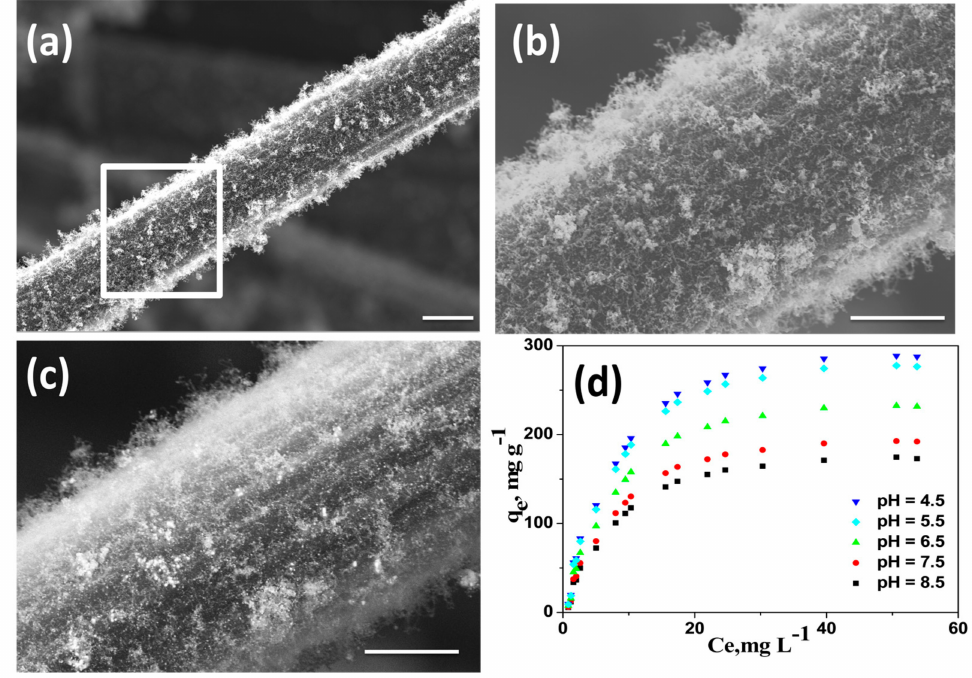
Figure 4. Representative SEM micrographs of Fe@NCNT-CF hybrid synthesized by from wPET at low ( a ) and high ( b ) magnifications; ( c ) is the secondary electron image showing presence of iron nano-particles; Scale bars are 50 µ m in ( a ) and 1 µ m ( b ) and ( c ); Adsorption isotherms of bisphenol A on Fe@CNT-CF nanostructures at various pH ( d